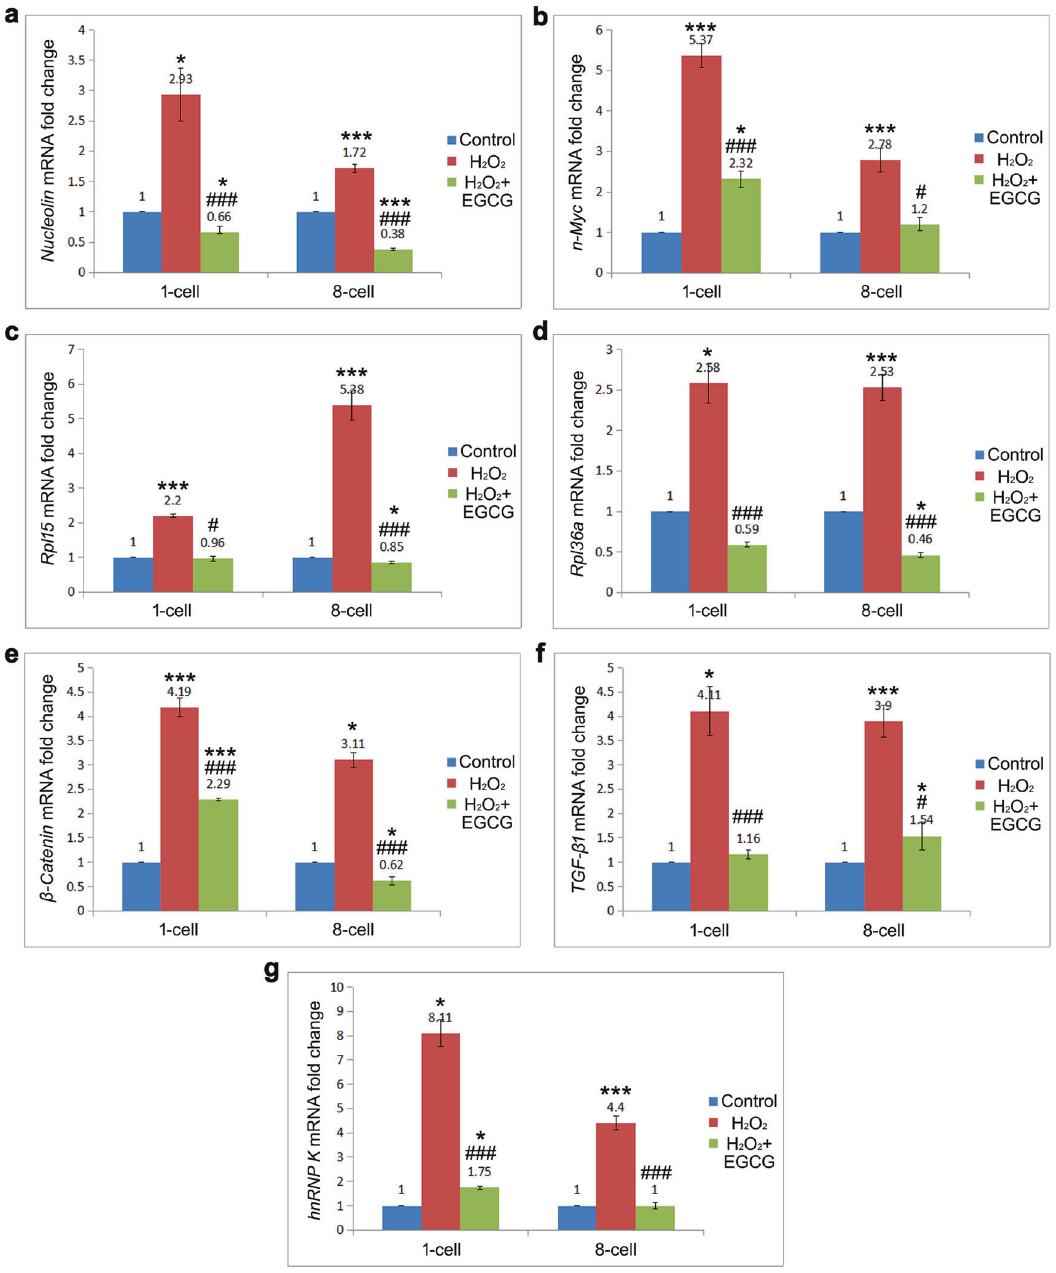
Fig. 8 mRNA levels of the key ribosome-/tumor-related differentially expressed proteins Nucleolin, n-Myc, Rpl15, Rpl36a, hnRNP K, β -Catenin, and TGF- β 1 by RT – qPCR. Data are expressed as the means ± SDs, collected from three independent experiments. Differences among groups were analyzed using Student ’ s t test. * P < 0.05 and *** P < 0.001 vs. control, # P < 0.05 and ### P < 0.001 vs. H 2 O 2 regulatory functions involving binding to select critical target the upregulation of Nucleolin promoted Wnt/ β -Catenin signaling, mRNAs 14 . For example, hyperactive ribosome biogenesis can drive which globally affects multiple steps in ribosome biogenesis and enhances the expression of nearly all ribosomal proteins via a activation of oncogenes (e.g., En2 and n-Myc ) and silencing of Myc-dependent pathway 47 . Myc (both c-Myc and n-Myc) has been tumor suppressor genes (e.g., Per2 and Diras2 ) in oxidatively shown to serve as a direct positive regulator of ribosome biogenesis 30 . ROS caused an increase in n-Myc (not c-Myc), some biogenesis can trigger the concomitant activation of tumor- related signaling pathways. Here, we show, for the fi rst time, that suggesting that n-Myc may be the critical molecule by which Wnt/ β -Catenin signaling regulates ribosome biogenesis in preimplan- oxidative damage establishes oncogenic cooperation among the ribosome, Wnt, and TGF- β 1 signaling pathways in IVF-derived tation embryos. embryos. As mentioned above, oxidative damage activates the Ribosome biogenesis in cancer depends on multiple factors. In Wnt/ β -Catenin signaling pathway, which stimulates the expression addition to protein synthesis function, most ribosomal proteins of ribosomal proteins 47 . Conversely, knockdown of ribosomal can in fl uence cellular processes by performing extraribosomal